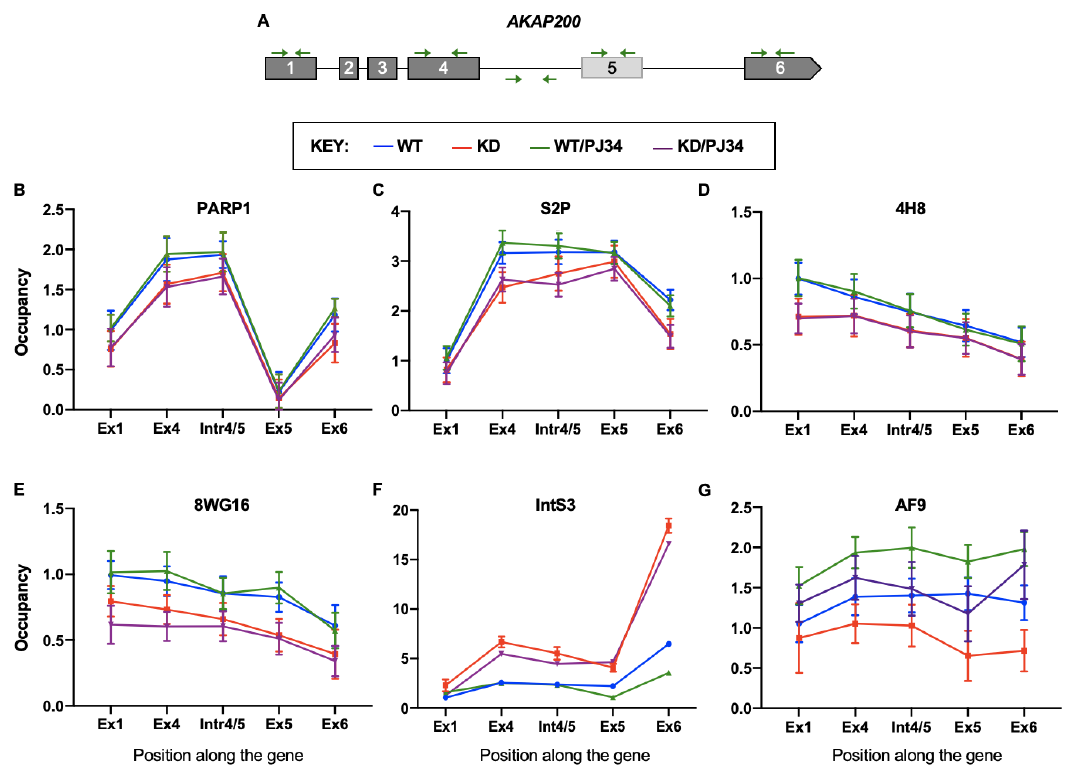
Figure 4. PARP1 and PARylation differentially impact localization/occupancy of elongation factors along the gene body of the AKAP200 gene. ( A ) Cartoon showing the location of primers used along the gene body of the AKAP200 gene. qPCR analyses of the occupancies of ( B ) PARP1, ( C ) elongating form of RNAPII (S2P), ( D ) Initiating form of RNAPII (4H8), ( E ) Initiating form, which is sometimes used for total RNAPII (8WG16). ( F ) Integrator subunit 3 (IntS3) and ( G ) AF9 (a member of the super elongation complex), along the AKAP200 gene body. All experiments were performed in triplicate, and results are presented as mean ± SD (the differences between treatment conditions observed, were statistically significant with a p value < 0.05). Statistical significance was tested by Student’s t - test method.